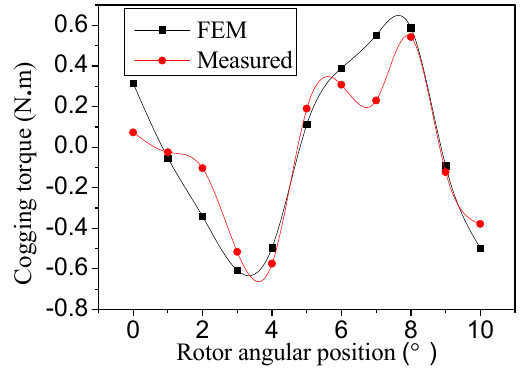
Figure 16. The measured and simulated cogging torque